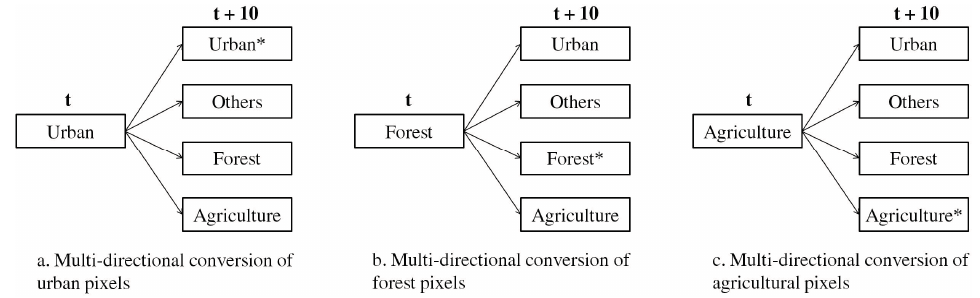
Figure 2. Three types of multi-directional conversions for three corresponding multinomial logistic regression (MNL) models (Note: Each model will be considered in two